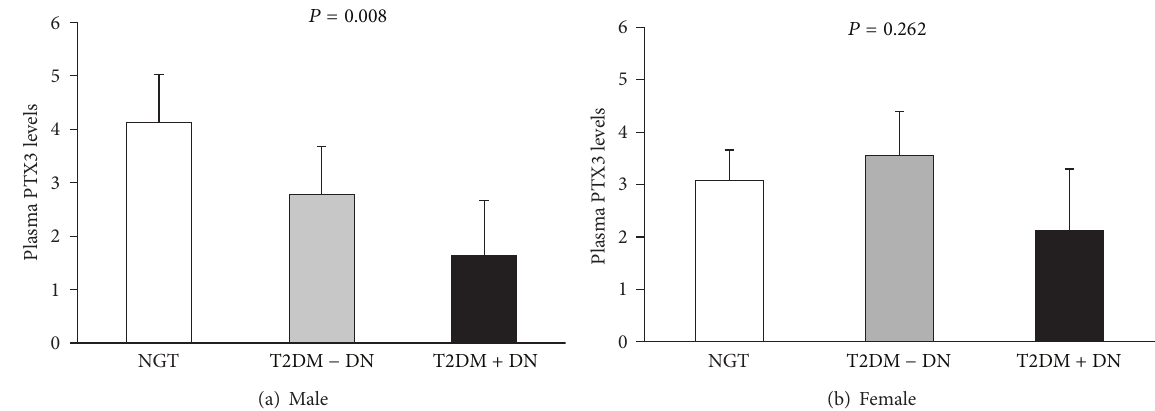
Figure 1: Plasma PTX3 levels in Malay subjects with normal glucose tolerance and type 2 diabetes patients with or without diabetic nephropathy.Datapresentedasmeanswith95%CI; 𝑃 valueswerefromANOVAtests;NGT:normalglucosetolerance;T2DM:type2diabetes; DN: diabetic nephropathy.